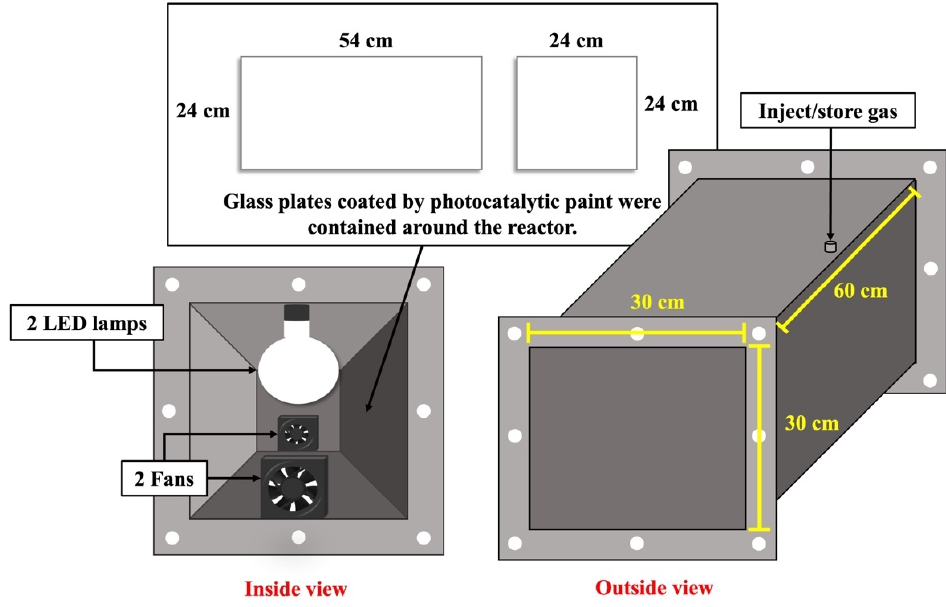
Figure 13. Schematic illustration of a closed stainless - steel reactor ( inside and outside views ) .